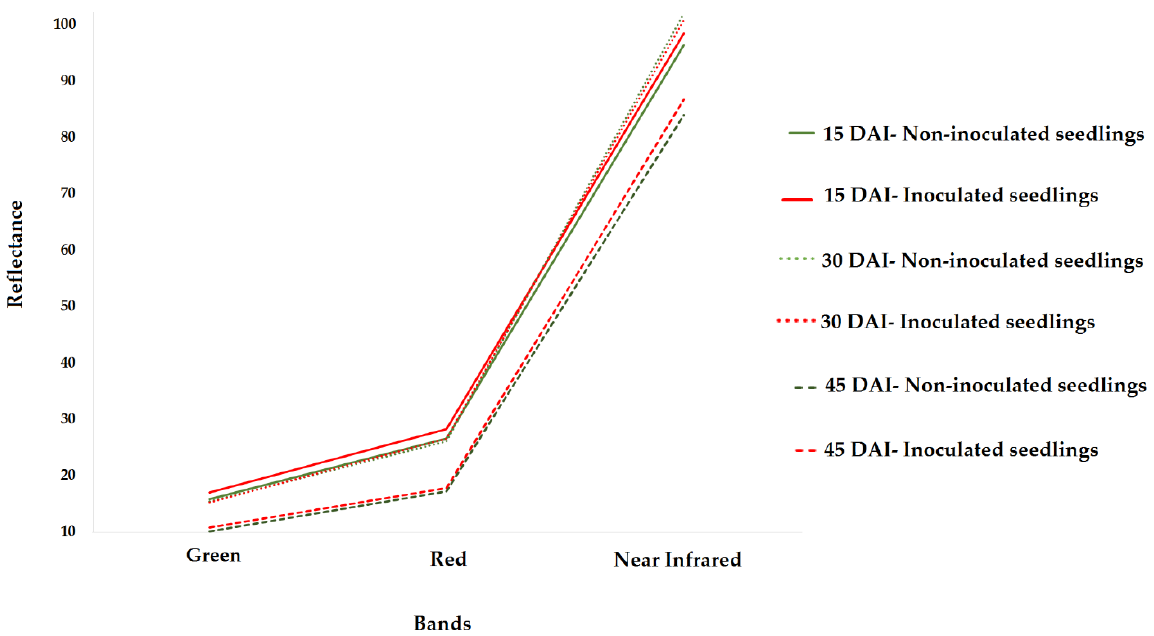
Figure 8. Spectral response of inoculated and non-inoculated coffee seedlings at 15, 30, and 45 days after inoculation (DAI) based on the average reflectance values of the RGN sensor images (red, green, and near infrared bands).